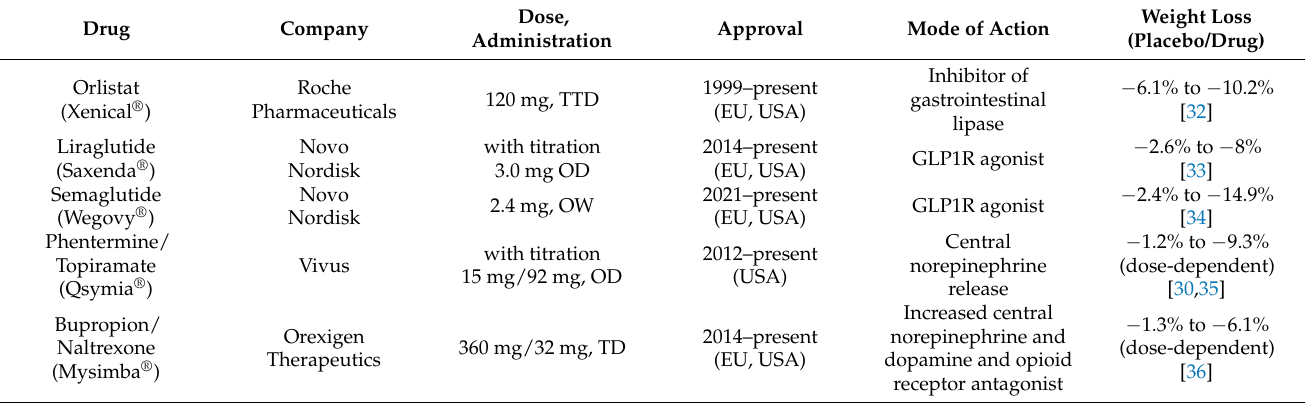
Table 1. Weight loss